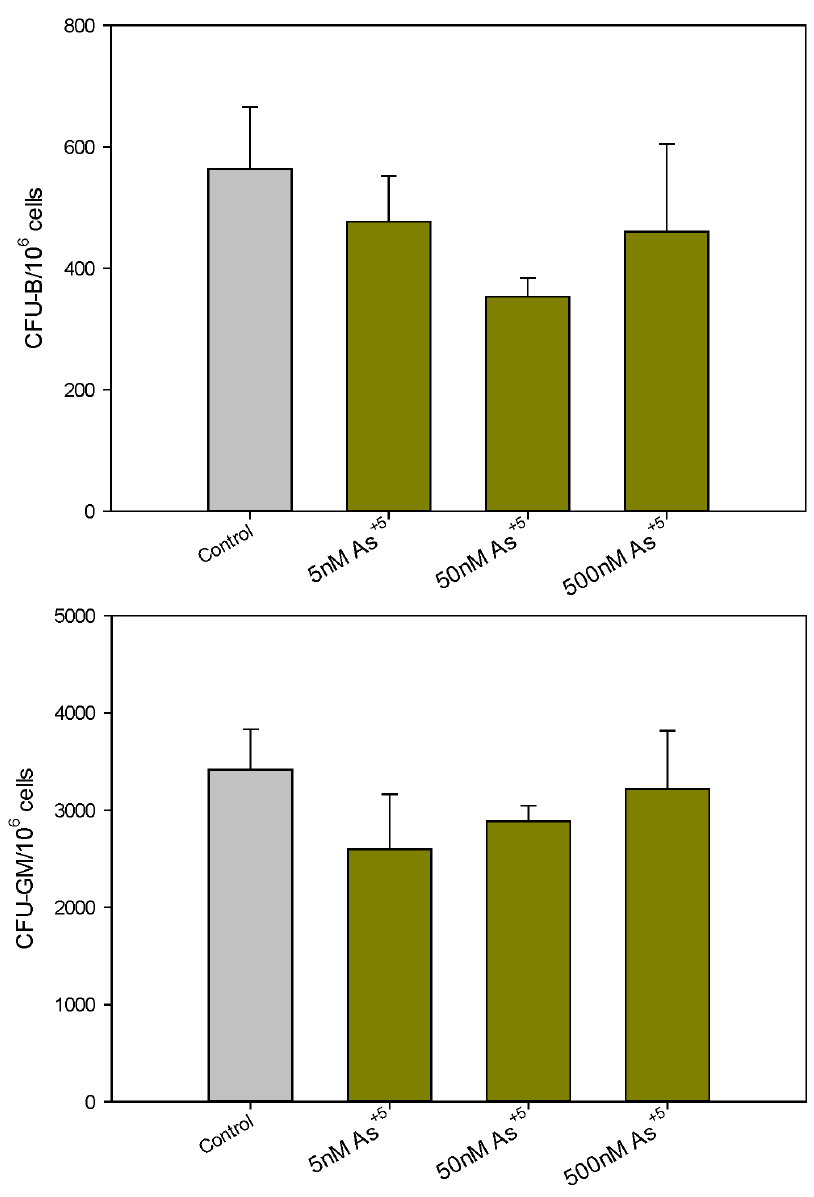
Figure 7. Number of colonies per million cells exposed to As + 5 invitro . Number of CFU-B colonies per million cells 10 days post plating in mouse methylcellulose media (containing As + 5 ) for pre-B cells [Top]. Number of CFU-GM colonies per million cells 14 days post plating in mouse methylcellulose media (containing As + 5 ) for GM cells [Bottom]. No significant differences between treatments and control (p , 0.05) were found. Results are Means + SD.